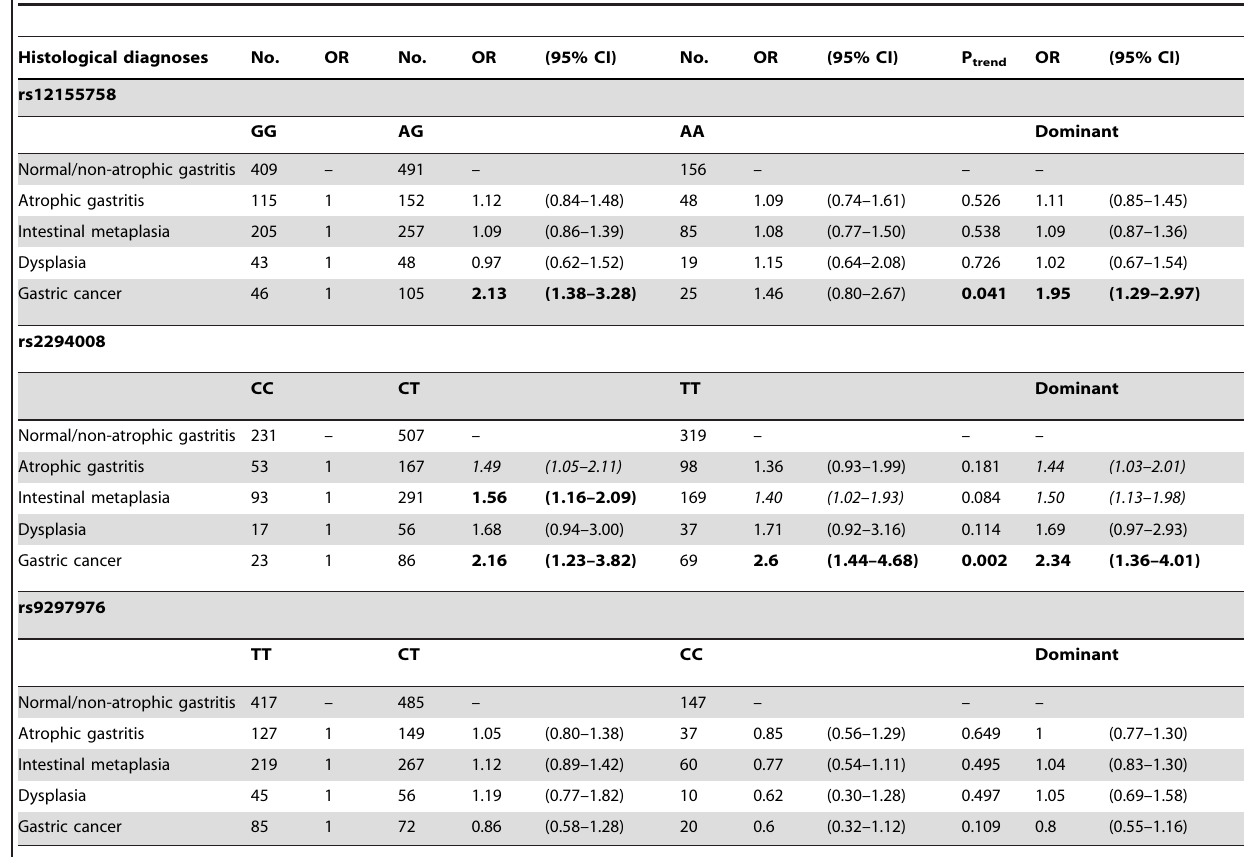
Table 2. ORs for precancerous lesions and GC, in comparison with normal or non-atrophic gastritis, according to individual PSCA